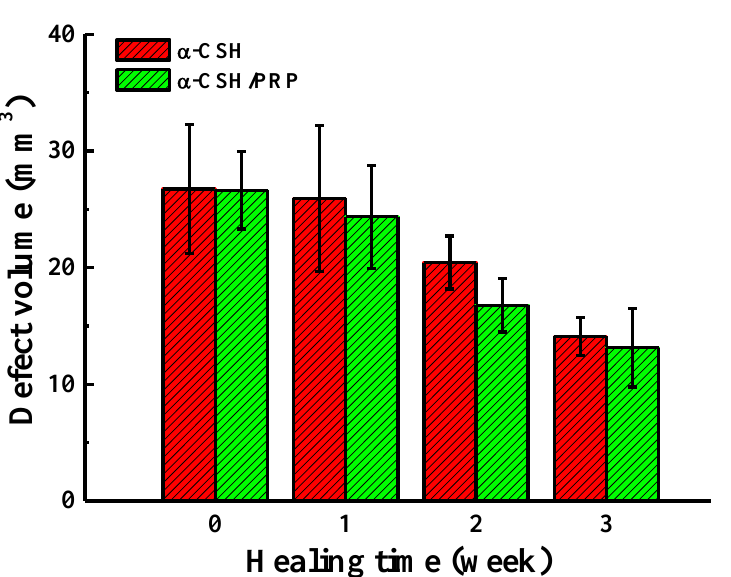
Figure 3. Defect volume of the sinuses at 0, 1, 2, and 3 weeks after treated with α-CSH and α- CSH/PRP bone graft.